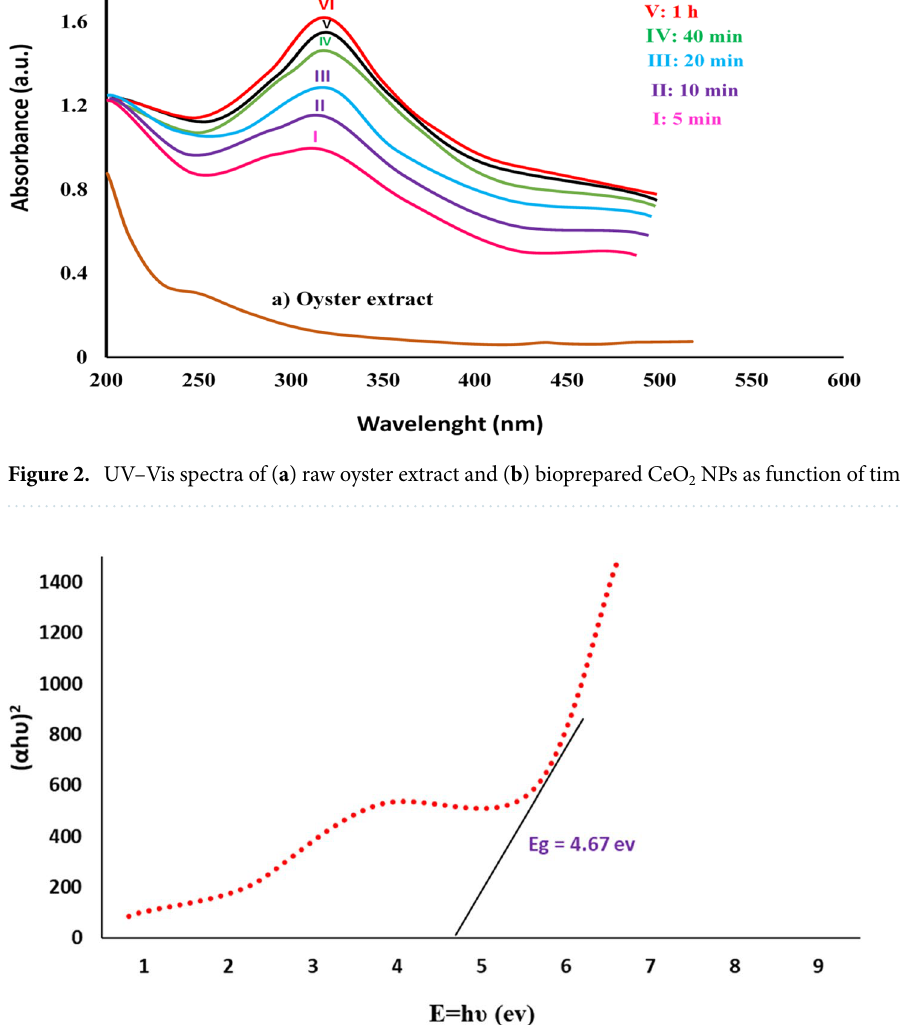
Figure 3. Tauc plot of biosynthesized CeO 2 NPs using marine oyster